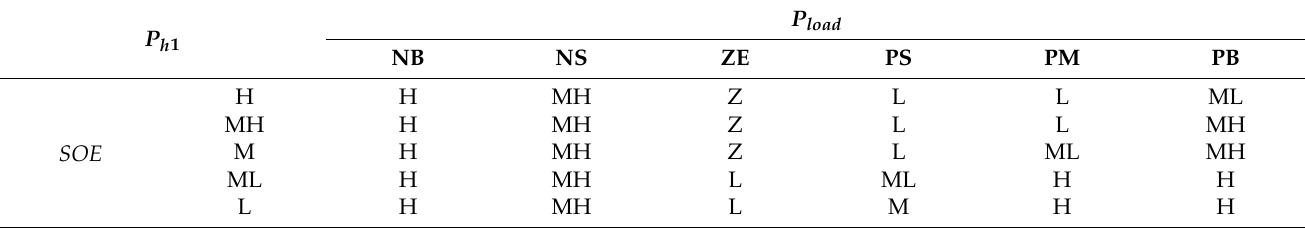
Table 3. Fuzzy rule for the low temperature condition.